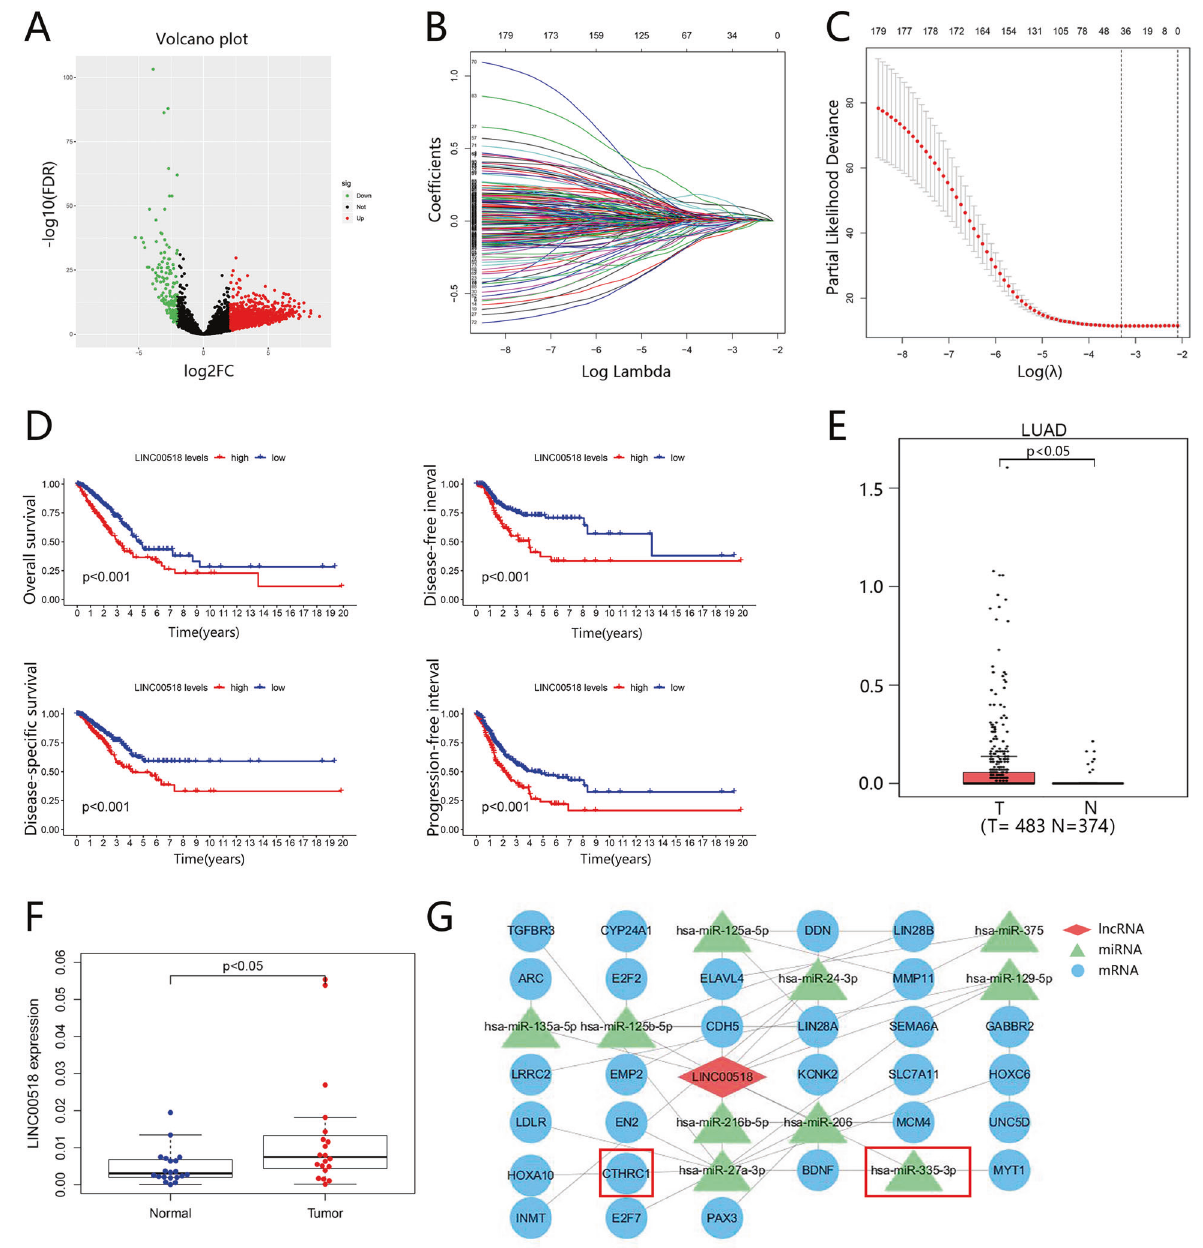
Fig. 1 Up-expressed LINC00518 was a venturesome factor for the survival of LUAD. A Differential expression of lncRNAs in LUAD was exhibited by volcano map. B Lambda of the LASSO regression of differentially expressed lncRNAs. C The minimum lambda included 39 lncRNAs. D The OS, PFS, DFS, and DSS of LUAD patients with high or low expression of LINC00518. Computed p-value by using the log-rank test. E LINC00518 is upregulated in LUAD compared with normal tissues. F The expression of LINC00518 was tested by qPCR in 20 paired LUAD tissues and their corresponding adjacent noncancerous lung tissues. G Cytoscape provided the visual interaction of LINC00518 − miRNA − target gene. resected the tissues from the xenograft tumors, and analyzed which is the drug target of VS-6063, was induced by Western them to verify LINC00518, and CTHRC1 by Western blotting and blotting analysis (Fig. 5J). qRT – PCR (Fig. 6D, E). Effect of LINC00518 in LUAD cells in vivo First, a xenograft mouse model was used to con fi rm the effect of LINC00518 in LUAD cells in vivo. As shown in illustration (Fig. 6A, B), tumors formed by LINC00518 knockdown cells were signi fi - cantly smaller in size than those formed by the contrast cells. cell proliferation while inhibiting miR-335-3p reversed this effect Tumor weights, in accordance with these results, were found to be (Fig. 7A). Additionally, it was identi fi ed that the cell survival lighter in cells with LINC00518 knockdown (Fig. 6C). Next, we